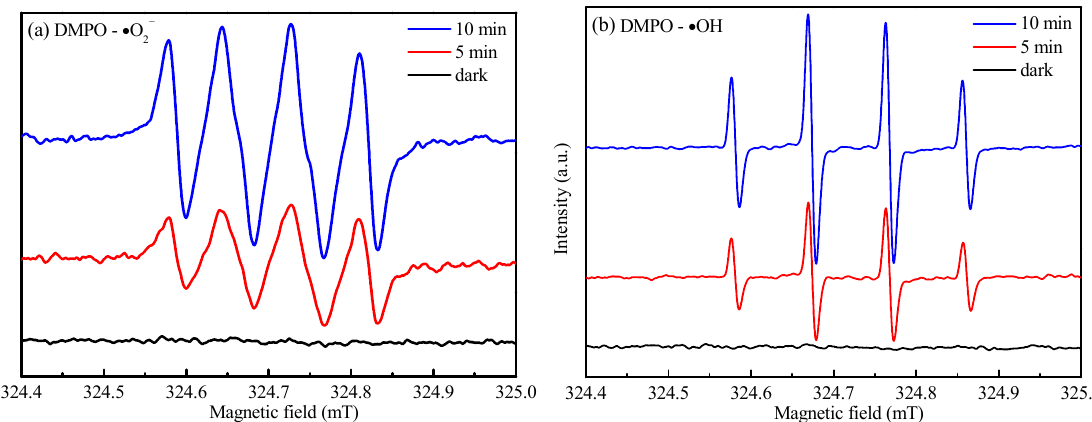
Figure 9. ESR spectra of Ag 3 PO 4 @5 mL NDC composite photocatalyst under dark and light condi- tions: ( a ) Capture of DMPO-·O 2 − in methanol dispersion system; ( b ) DMPO-·OH capture in aqueous dispersion system.